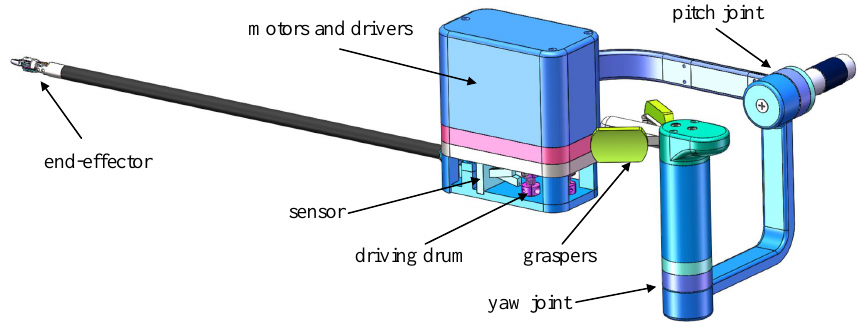
Figure 1. The sensor applied to investigation of force feedback and tactile sense in our prototype of laparoscope surgical robot is used to estimate and control the cable tension.